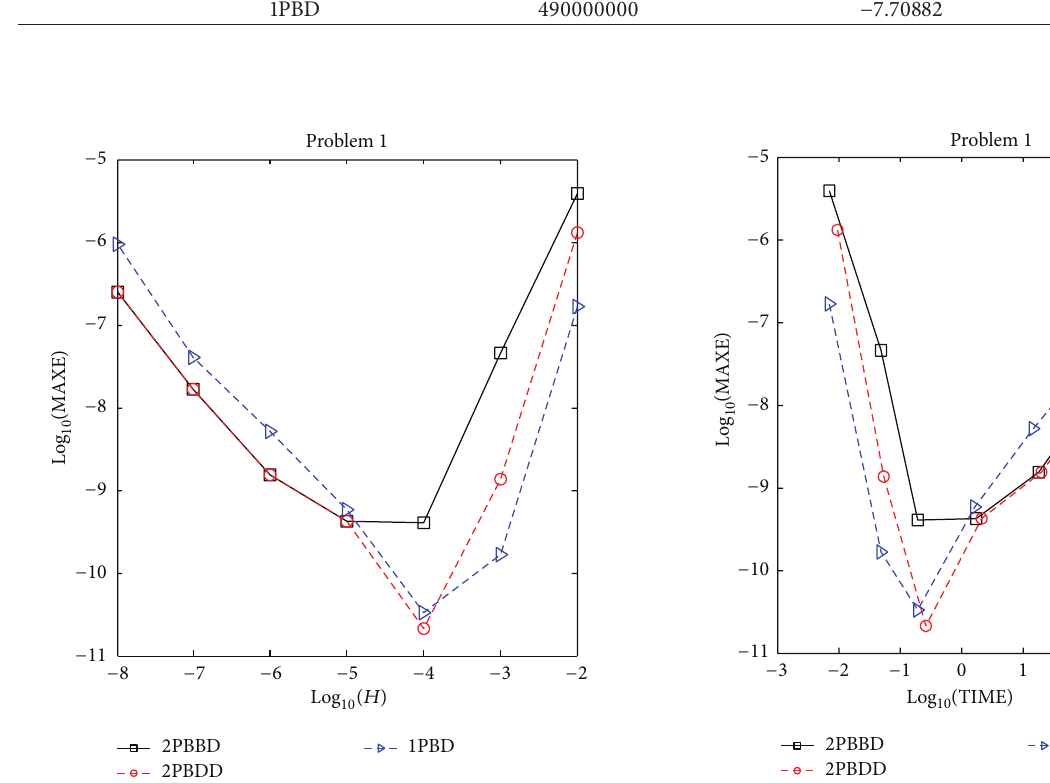
Figure 2: Graph of Log 10 ( MAXE ) plotted against Log 10 (𝐻) for Problem 1.